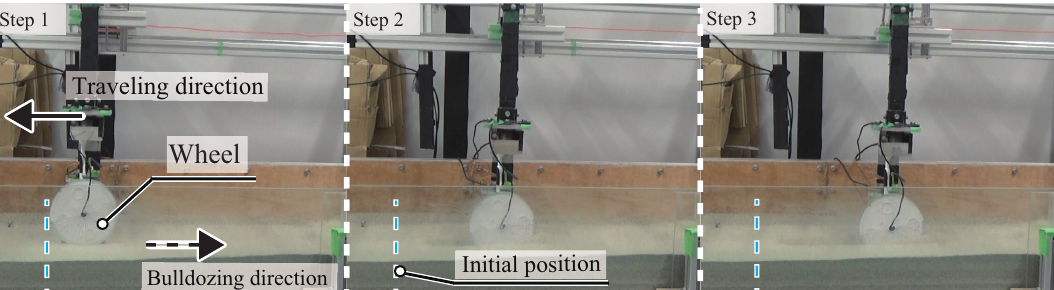
Figure 12. Actual image of wheel towing experiment. Diameter 0.17 m; width 0.04 m; mass 2.5 kg. The wheel was carefully set on the loose soil (step 1). Then, the rope towed the wheel unit (steps 2 and 3).